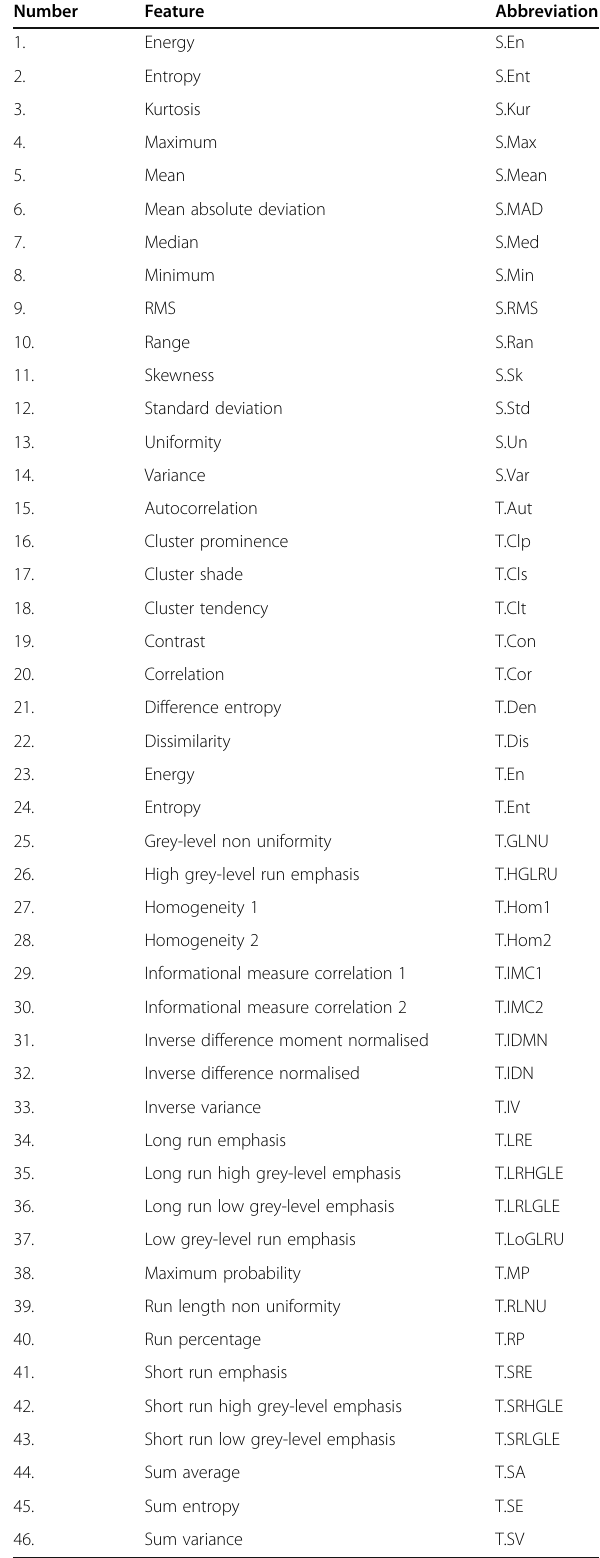
Table 2 List of computed statistic (S) and texture (T)